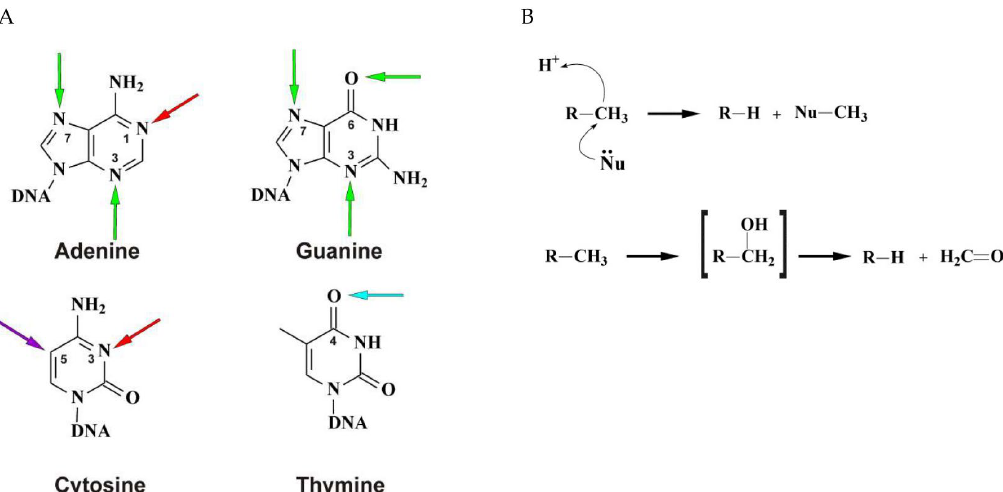
Figure 1. Methylation sites in nucleic acids. ( A ) Methylation positions in nitrogenous bases of a single- and double-stranded nucleic acid that are characteristic of the S N 1 mechanism (blue), S N 2 mechanism (red), or both types (green), epigenetic enzyme-catalyzed cytosine methylation (violet). ( B ) Schemes of demethylation via the mechanisms of nucleophilic substitution and oxidative demethylation.